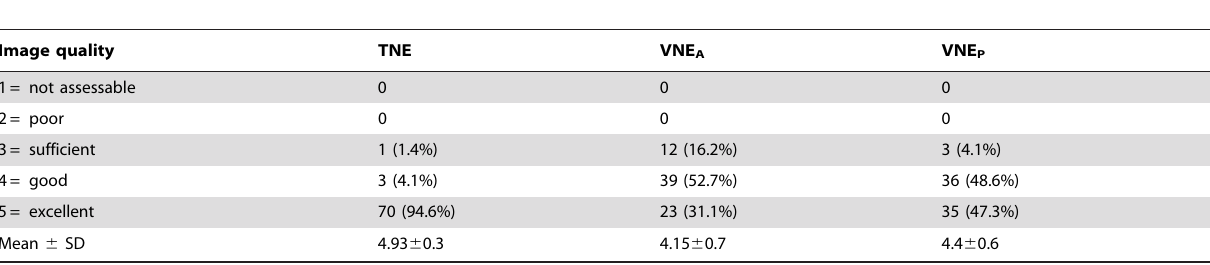
Table 2. Image quality true non-enhanced and virtual non-enhanced images.